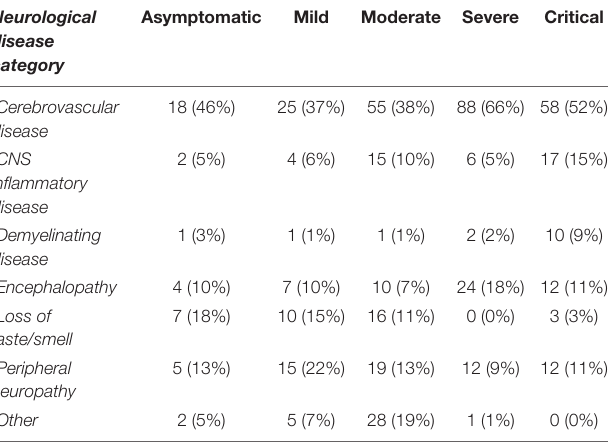
TABLE 3 | Frequencies and percentages of neurological disease, COVID-19 severity, comorbidities, and detectable virus in CSF by sex. Variable n Female Male Not Neurological disease category 510